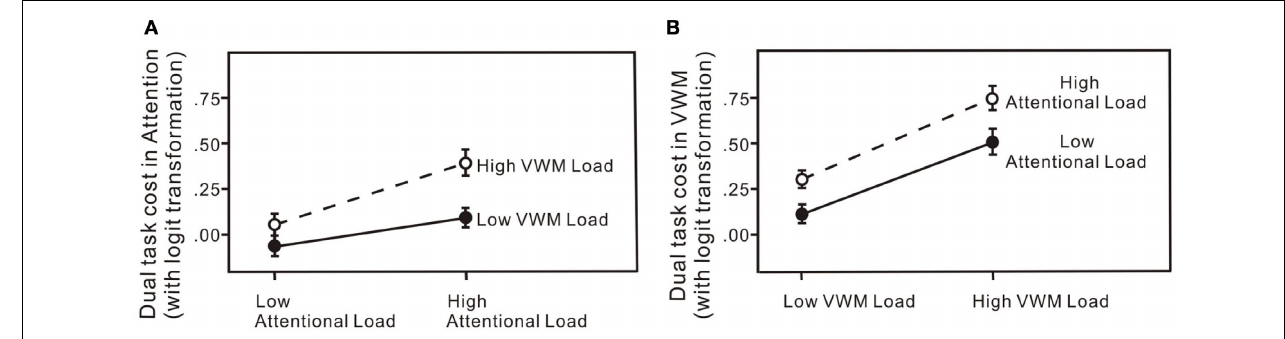
FIGURE 7 | Dual-task costs (percentage error) for: (A) the attentional task across the four experiments; (B) theVWM task across the four experiments.The error bars represent ± 1 SE computed using Loftus and Masson’s (1994) method for within-subject designs.